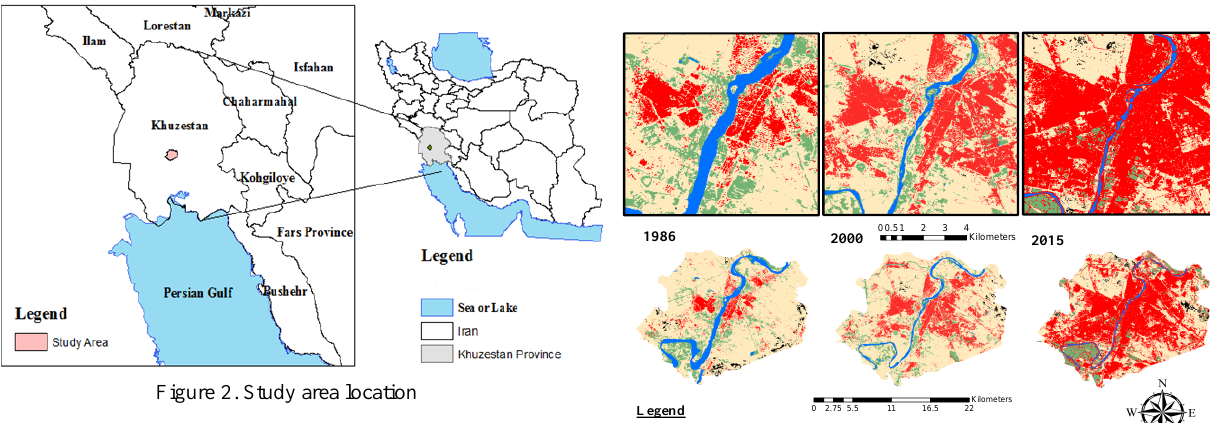
Figure 2. Study area location